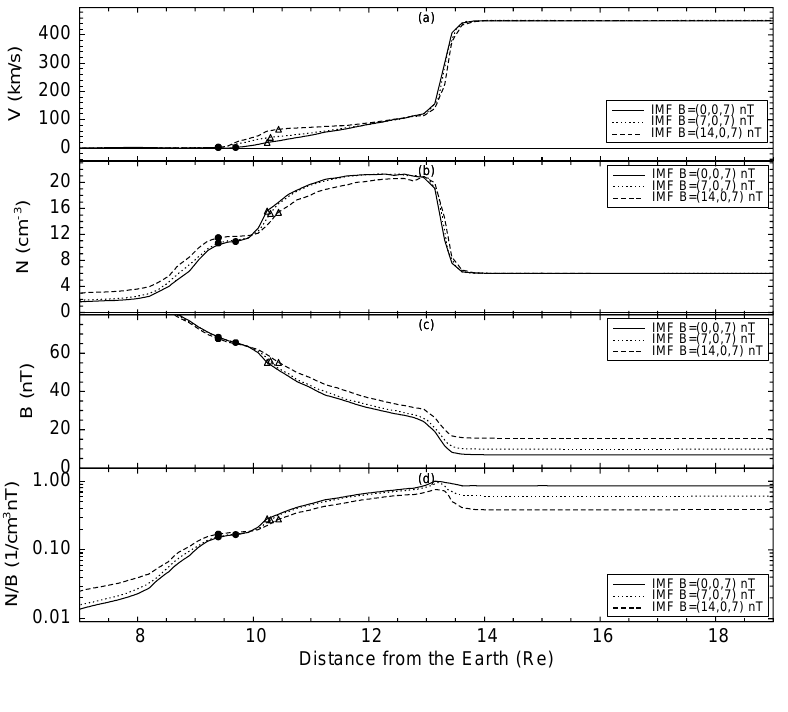
Table 5. The dependence of some important parameters on the IMF clock angle along the Sun-Earth line in Fig. 9. Clock angle ( ◦